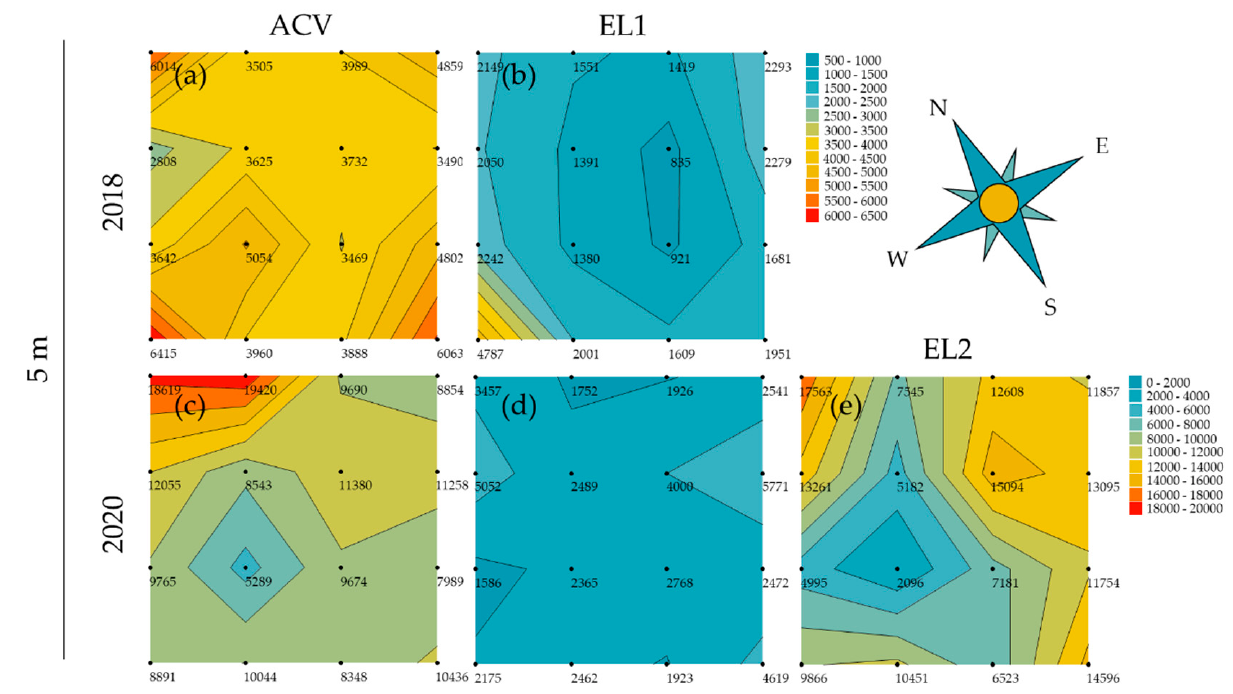
Figure 3. Contour plots for the trials in spring at 5 m inter-trap spacing. Each point of the 4 × 4 grids represents the pooled D. suzukii (male and female) trap catches for a trap position over the whole spring (May and June) trial period and the four replicate grids. The contour plots for ( a ) ACV and ( b ) EL1 in 2018 both show a clear depression in the centre of the grid. The plots are relatively sym- metrical and there is no evident relation with the mean NNW winds. In 2020, the contour plots of ( c ) ACV and ( e ) EL2 again show a similar depression in the centre whereas this is not seen for ( d ) EL1. Additionally, here no evident relation with the mean wind direction (WSW) can be observed.